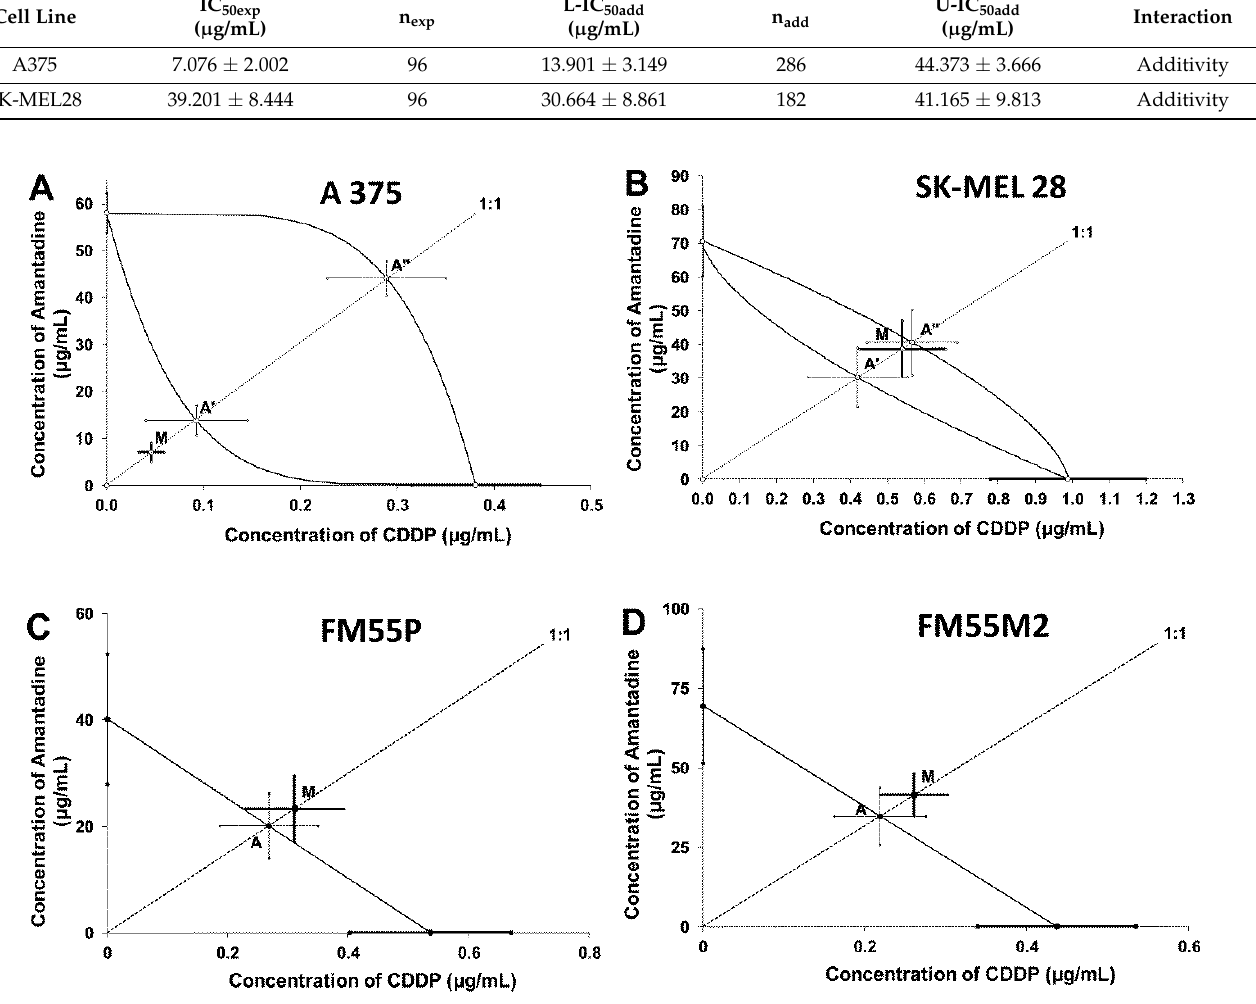
Figure 9. Isobolograms display additive interaction between amantadine and CDDP with respect to their anti-proliferative effects on A375 ( A ), SK-MEL28 ( B ), FM55P ( C ) and FM55M2 ( D ) melanoma cell lines measured in vitro by the MTT assay. The IC 50 ± S.E.M. (as the error bars) for amantadine and CDDP are plotted on the X- and Y-axes, respectively. The points A, A ′ and A ″ depict the theoretically calculated IC 50add values (±S.E.M.). The point M on each graph represents the experimentally-derived IC 50exp value (±S.E.M.) for the mixture, which produced a 50% anti-viabilitive effect in the melanoma cell lines. Although point M is placed below the point A ″ for the A357 cell line ( A ), the two-drug combination produced additivity in the MTT assay. For the SK-MEL28 cell line, the point M is placed between both points A ′ and A ″ within the area of additivity indicating additive interaction between amantadine and CDDP ( B ). In the case of the FM55P ( C ) and FM55M2 ( D ) cell lines, point M is placed slightly above point A, indicating additive interaction for amantadine with CDDP in the MTT assay.